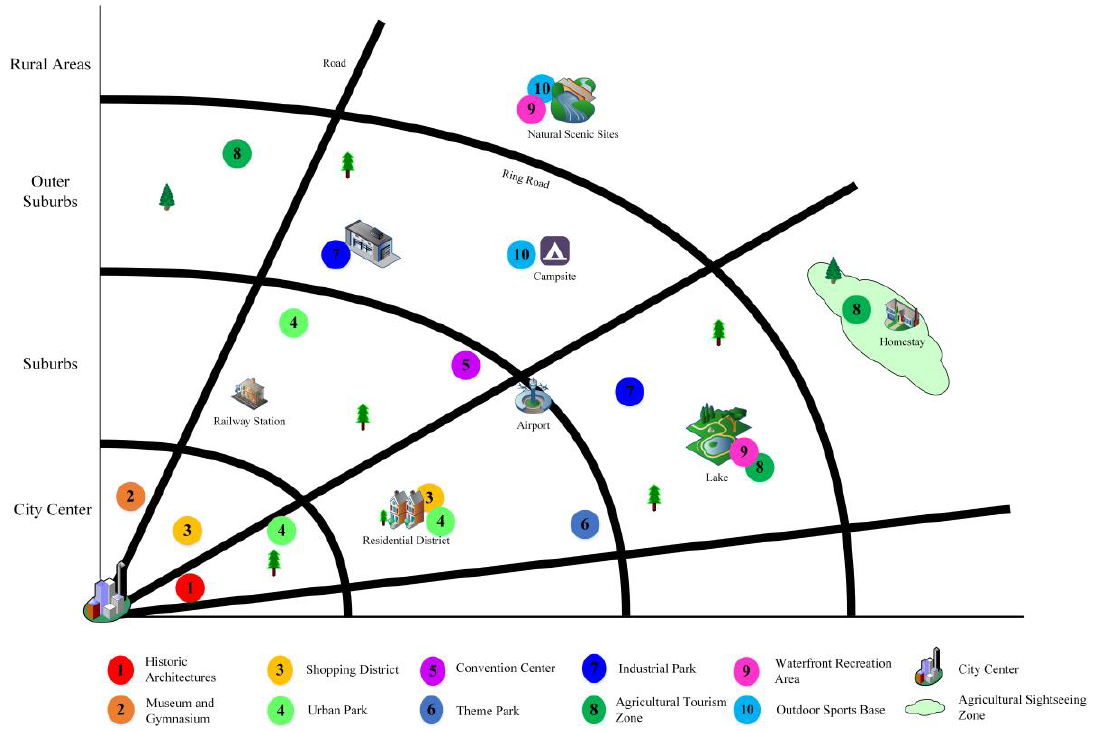
Figure 4. The distribution of tourism space in the city.